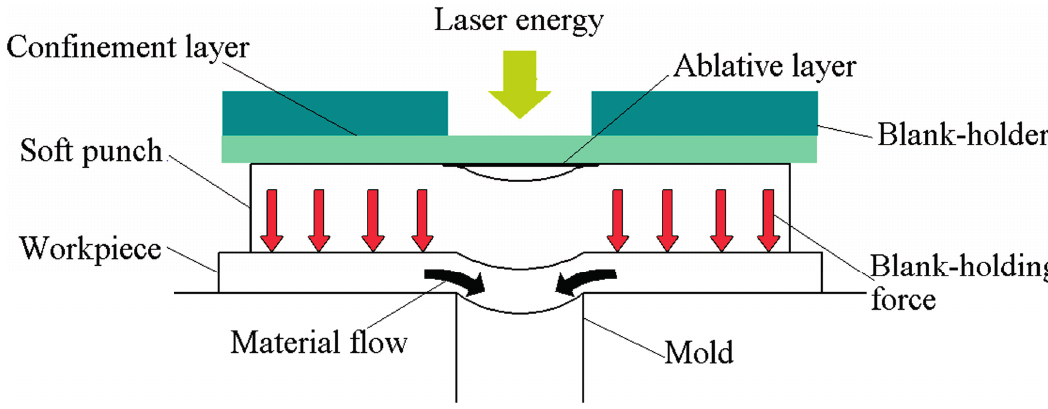
Figure 10. The deformation behavior in laser shock punching